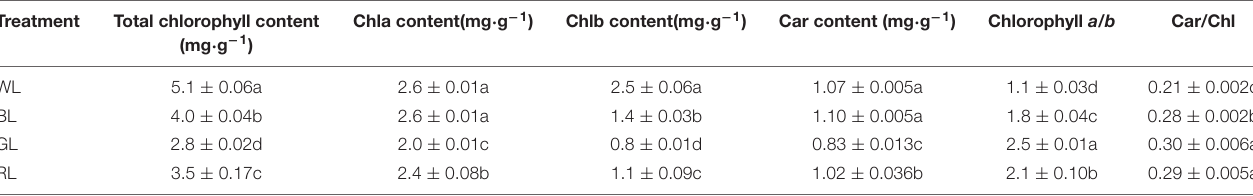
TABLE 4 | Chlorophylls levels, Chlorophyll a/b and Car/Chl in C. paliurus exposed to different light quality (Means ± SD). Treatment